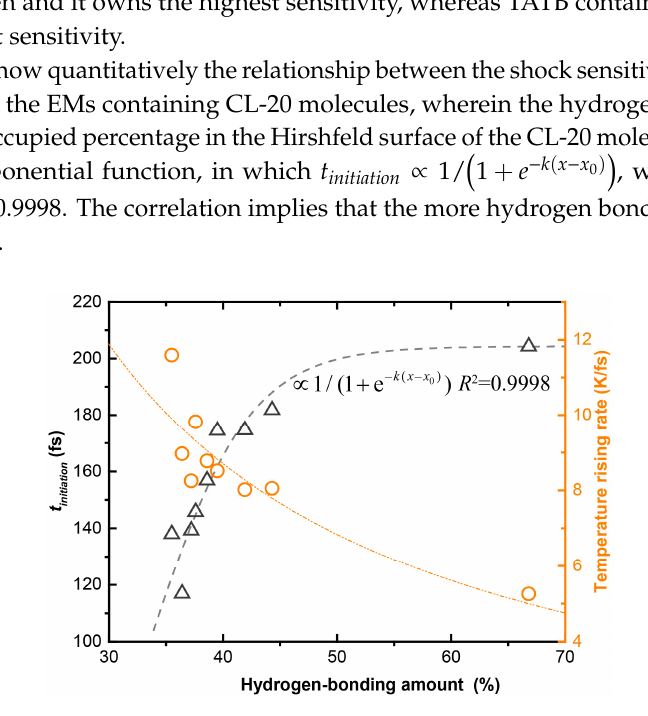
Figure 7. Shock sensitivity vs amount of hydrogen bonding for the CL-20 composed EMs studied.